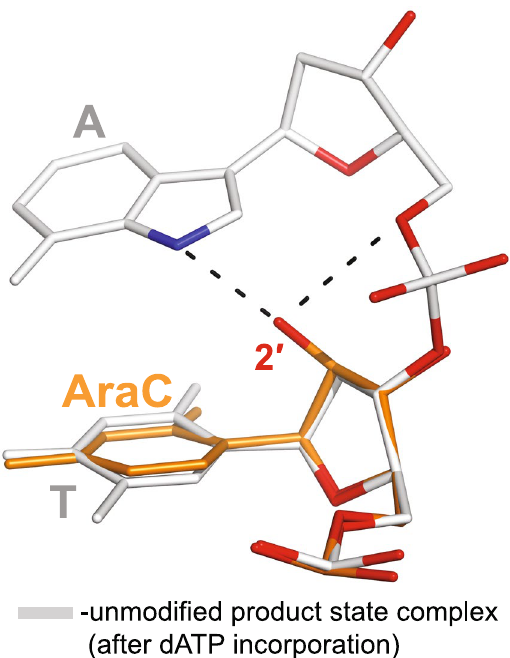
Figure 5. Model of the Pol η AraC extension product complex. The C3 ′ - endo AraC is superimposed onto the penultimate primer base in the product state of the unmodified complex after covalent insertion of an adenine base (PDB ID: 4ECX, 300 sec reaction time) 30 . The 2 ′ -OH of the AraC makes hydrogen bonds with the O5 ′ of the phosphate group and with the N7 acceptor atom of the just incorporated adenine